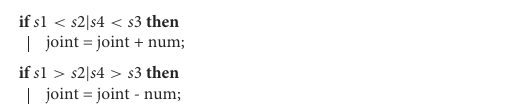
Algorithm 5 Ankle control